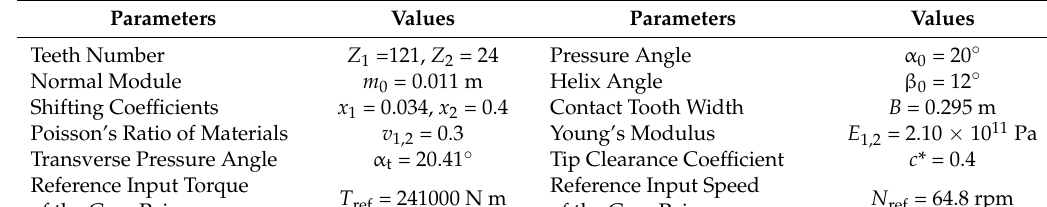
Table 1. The gear parameters from the authors’ studies.